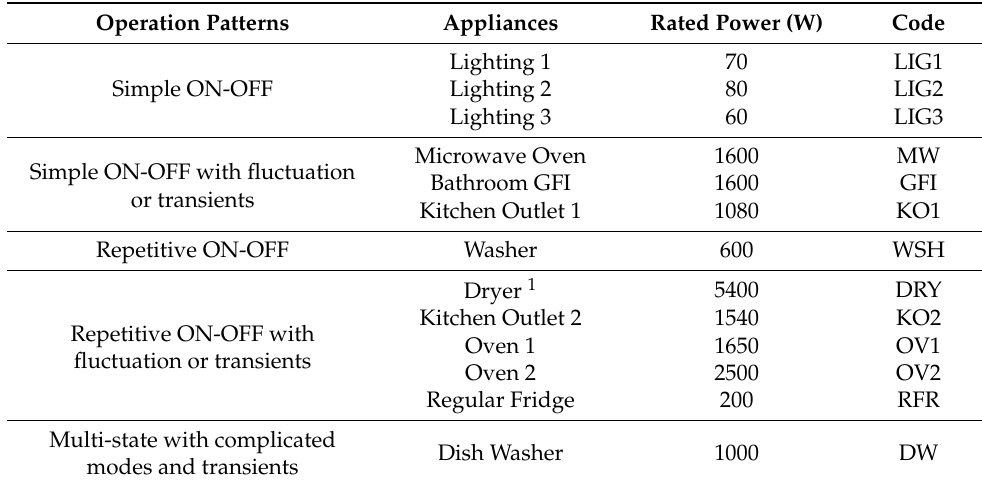
Table 6. The basic information of studied appliances in House 1 of